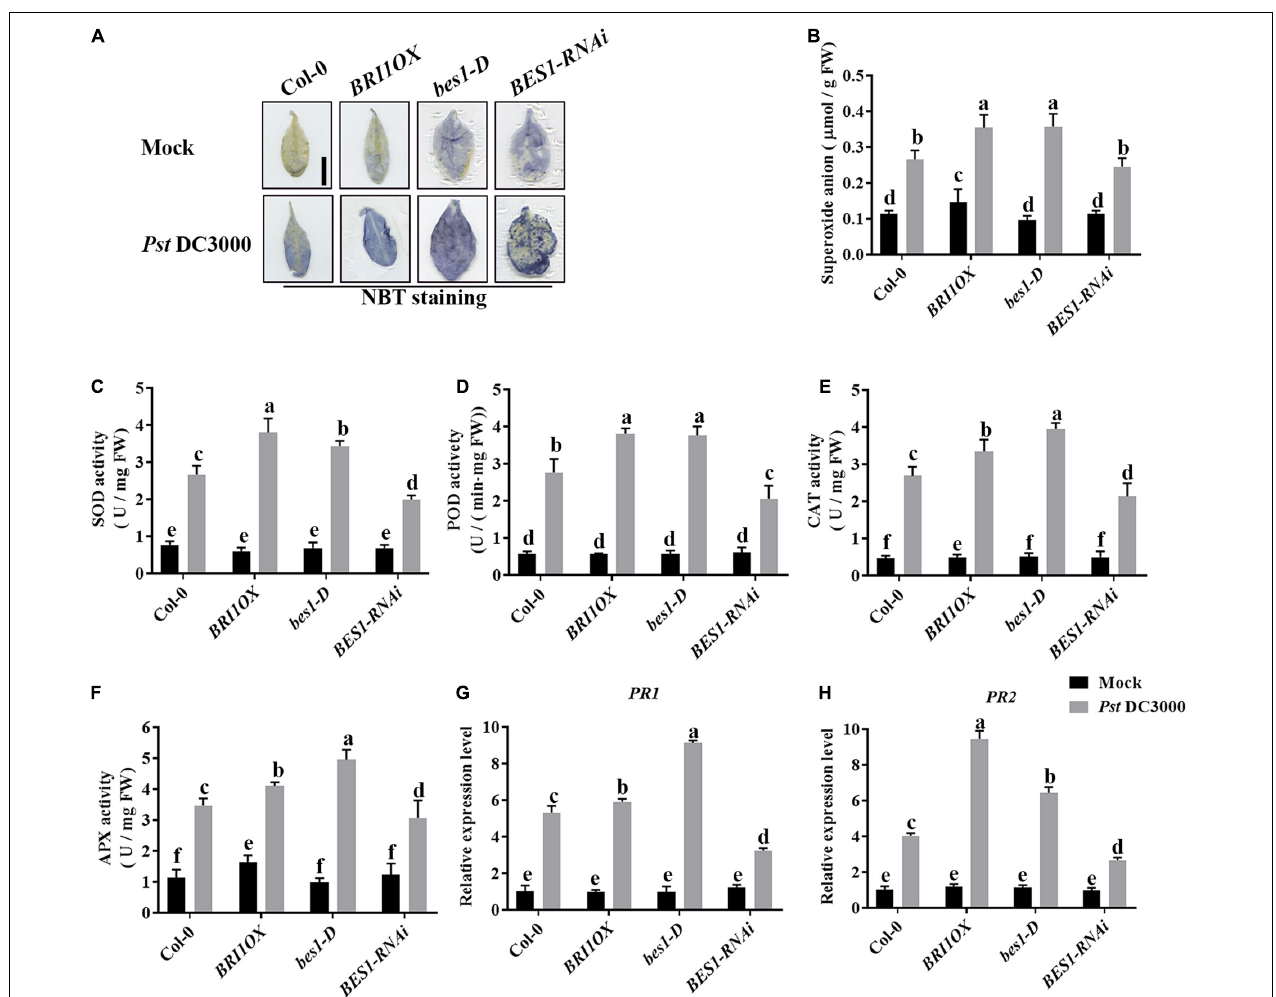
FIGURE 7 | Brassinosteroid signaling enhances the antioxidant system to defend against pathogens. (A) NBT staining for observing superoxide accumulation at 1 dpi in Col-0, BRI1OX , bes1-D , and BES1-RNAi. Bar, 1.00 cm. (B) The superoxide content in the infected leaves at 1 dpi. The activities of the antioxidant enzymes SOD (C) , POD (D) , CAT (E) , and APX (F) . Bars represent mean ± SD obtained from three biological replicates per genotype and time point, superoxide content or the activities of the antioxidant enzymes measured from five leaves of each genotype and treatment were pooled for one replicate. (G,H) Relative expression levels of defense-related genes PR1 and PR2. The expression of ACTIN2 was used as an internal reference. Data presented are mean ± SD from three independent experiments. Significant differences ( P < 0.05) are denoted by different lowercase